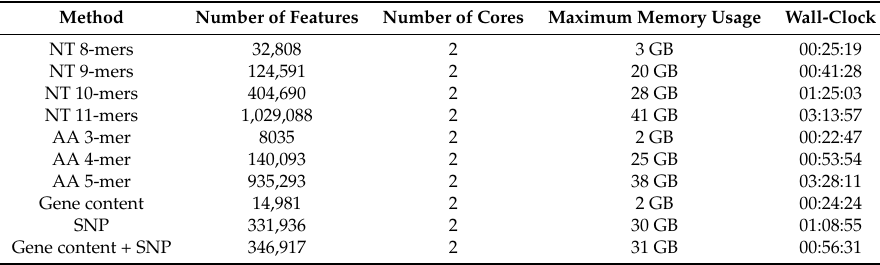
Table A67. Resources for C. jejuni –erythromycin.